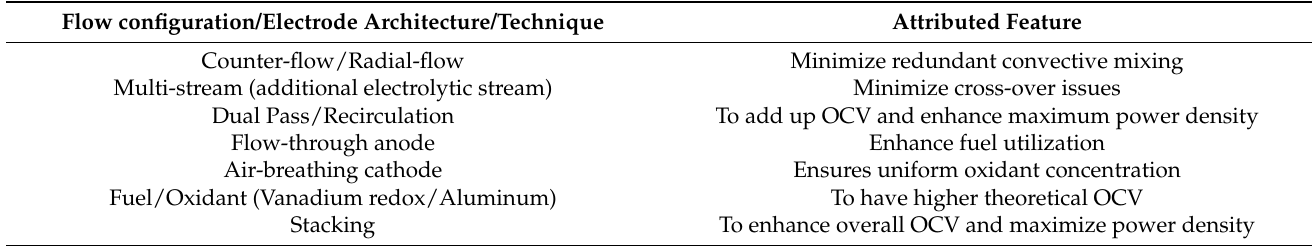
Table 5. Insights into next-generation MMFC components and flow